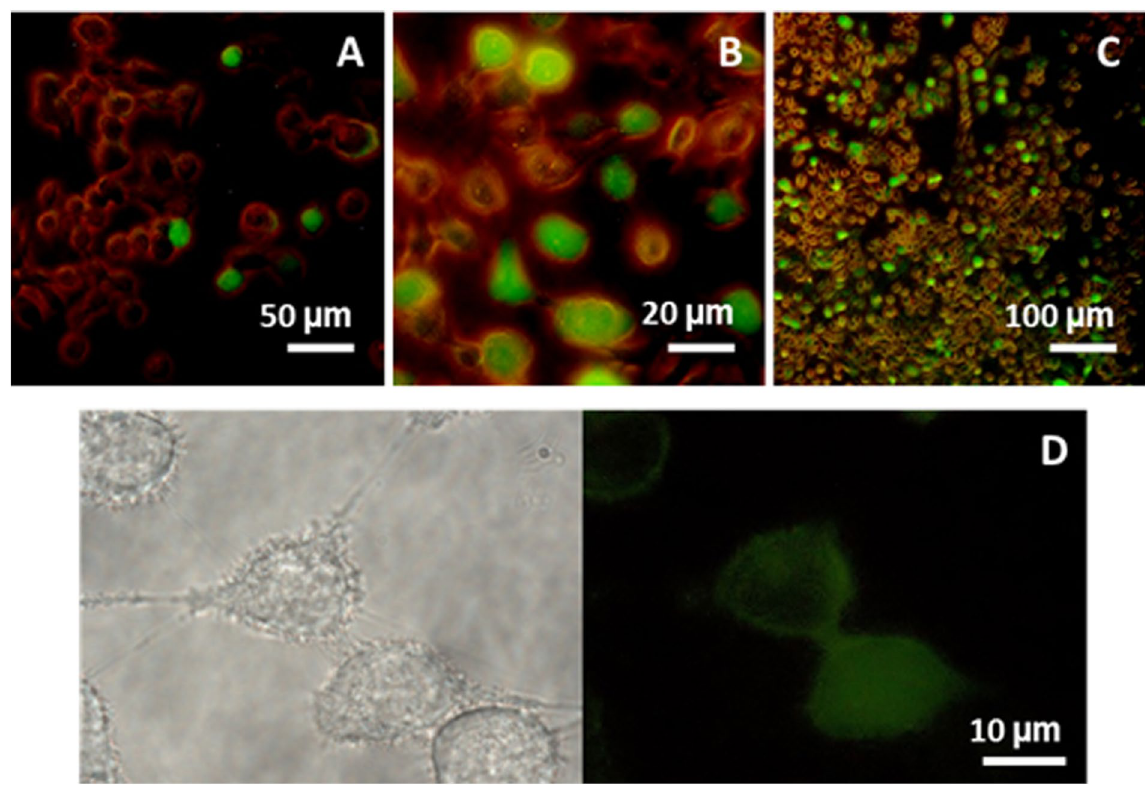
Figure 2. Microscopy images acquired on HaCaT cells treated with 1 MHz US at I spta = 7 mW/cm 2 . FITC fluorescence together with low intensity transmitted phase contrast images of cells sonicated for 15 ′ ( A ), 30 ′ ( B ) and 45 ′ ( C ); detail of cells sonicated for 45 ′ ( D ), acquired in phase contrast (left) and fluorescence (right), where a two-level uptake of the fluoroprobe (diffused in the cytosol and localized in the biological membrane) is